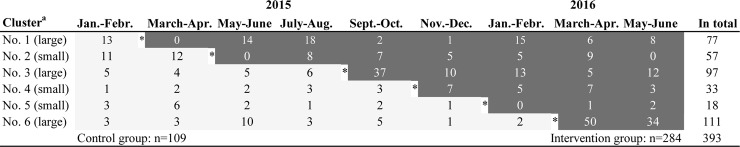
Stepped-wedge design, timeline, and patient recruitment rate.All 6 municipalities (clusters) started the trial simultaneously with a control phase (general practitioners and physiotherapists providing usual care). At predefined time points about every second month, one by one the municipalities crossed from the control to the intervention phase (use of the SAMBA model) in a randomised order. Light cells in the figure represent control periods, and dark cells represent intervention periods. The asterisks indicate the timing of the interactive workshops before switching to the intervention phase. Patients recruited to the study during the control phase in any cluster constituted the control group, whereas patients recruited during the intervention phase constituted the intervention group. All patients responded to the baseline questionnaire and follow-up questionnaires at 3, 6, 9, and 12 months post-baseline. aLarge municipalities (clusters) had >20,000 inhabitants.